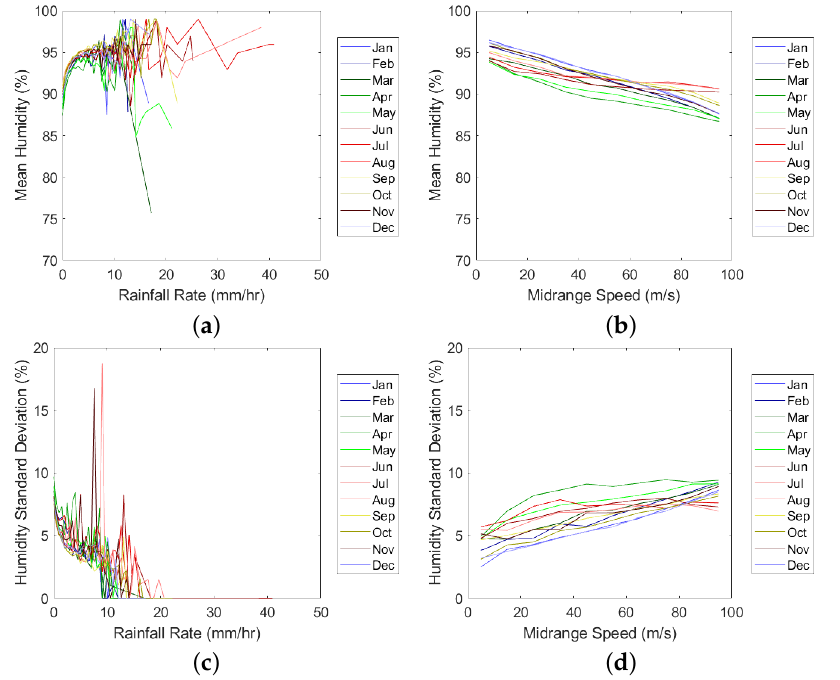
Figure 23. Mean ( a , b ) and standard deviations ( c , d ) of data presented in Figure 22 against the midrange tip speed of each bin for the respective stations.